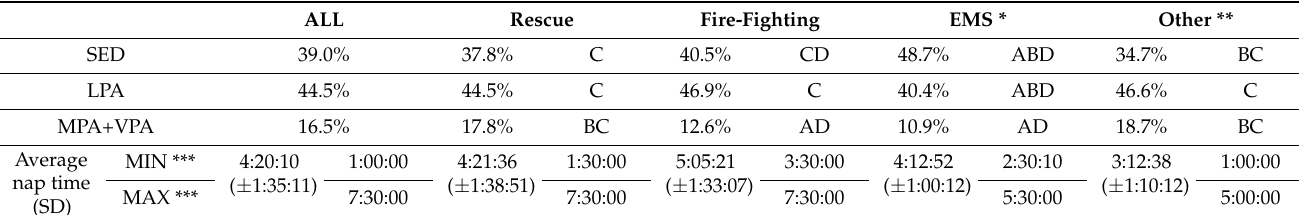
Table 2. Intensity of activity Group and Average nap